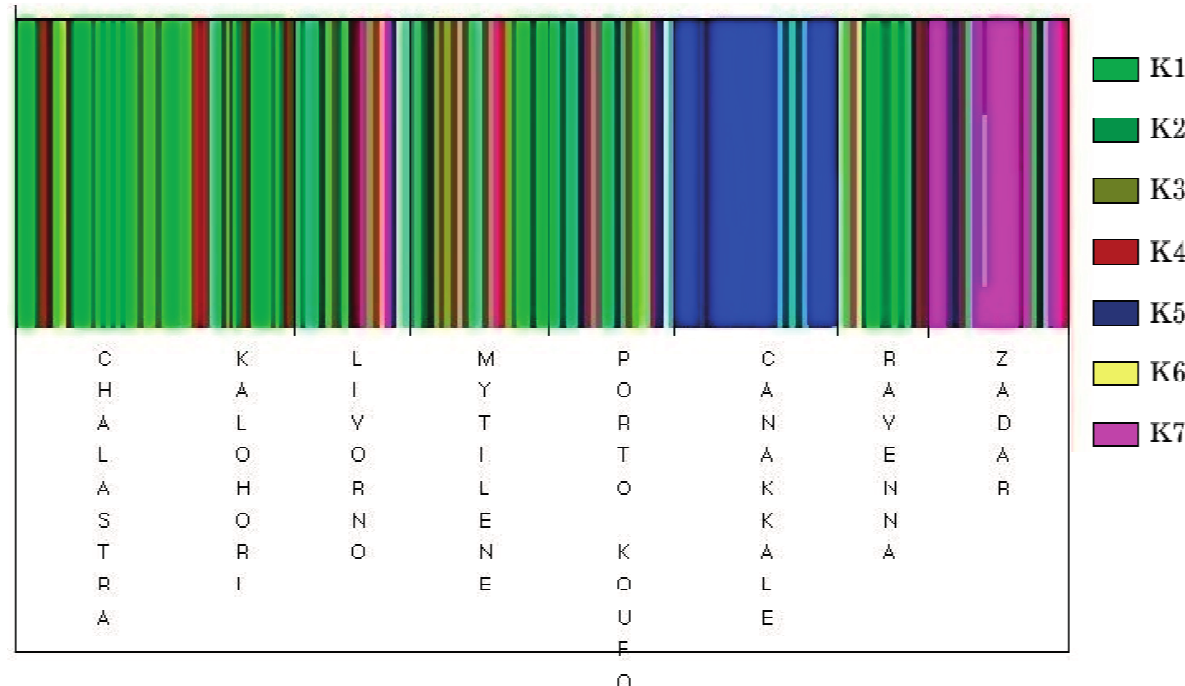
Figure 1. Bayesian admixture analysis of individuals. Each color represents one distinct haplogroup (cluster) while each bar represents a different